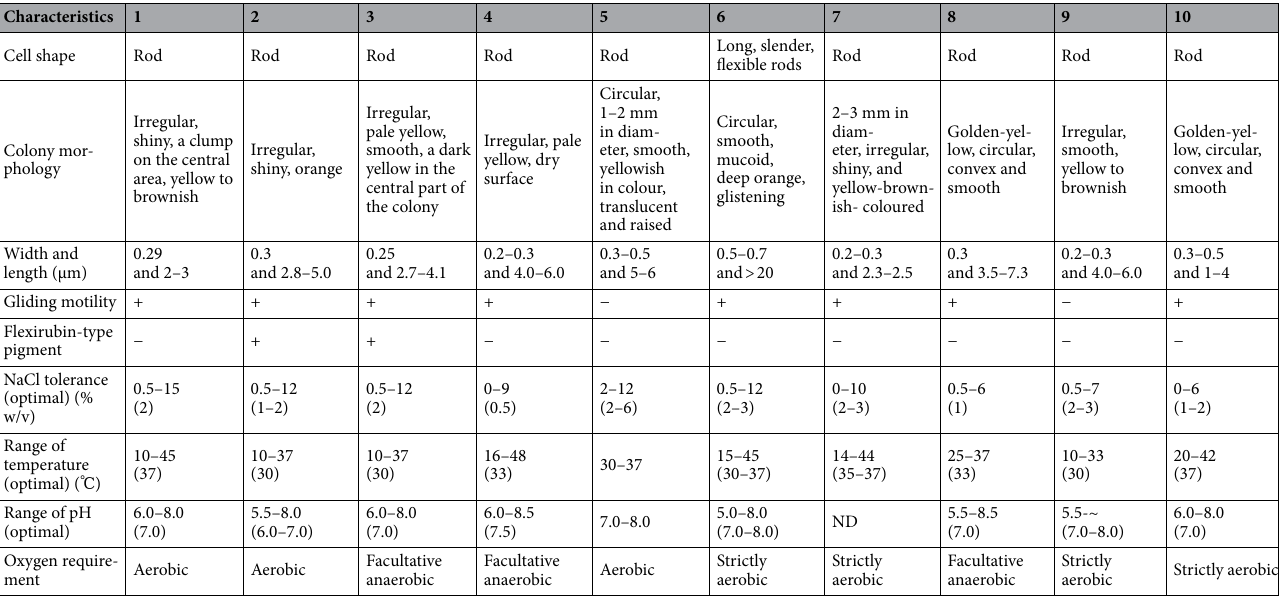
Table 1. Comparative physiological characteristics of three novel strains SS9-22 T , W9P-11 T , SW1-E11 T and their reference strains in genus Fulvivirga . Taxa: 1, SS9-22 T ; 2, W9P-11 T ; 3, SW1-E11 T ; 4, F. sediminis 2943 T 45